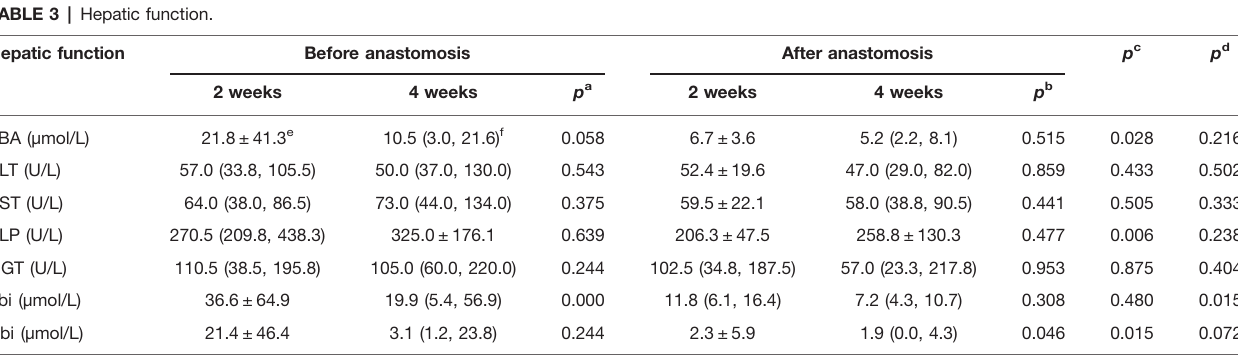
TABLE 3 | Hepatic function. Hepatic